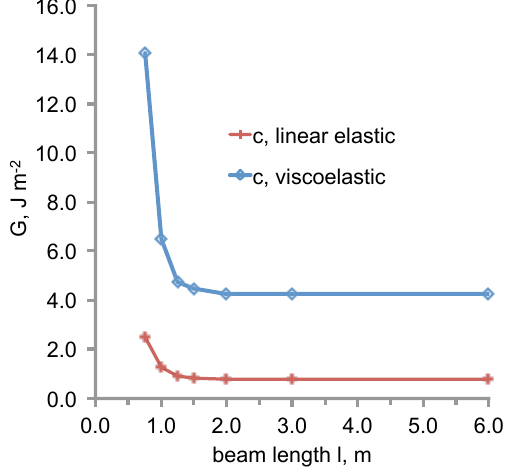
Figure A1. Energy release rate G vs. beam length l for two ver- sions of the FE model run on profile c . The curve “ c , linear elastic” shows results from a model assuming linear elastic behavior, while the curve “ c , viscoelastic” shows results from a model incorporating viscoelastic